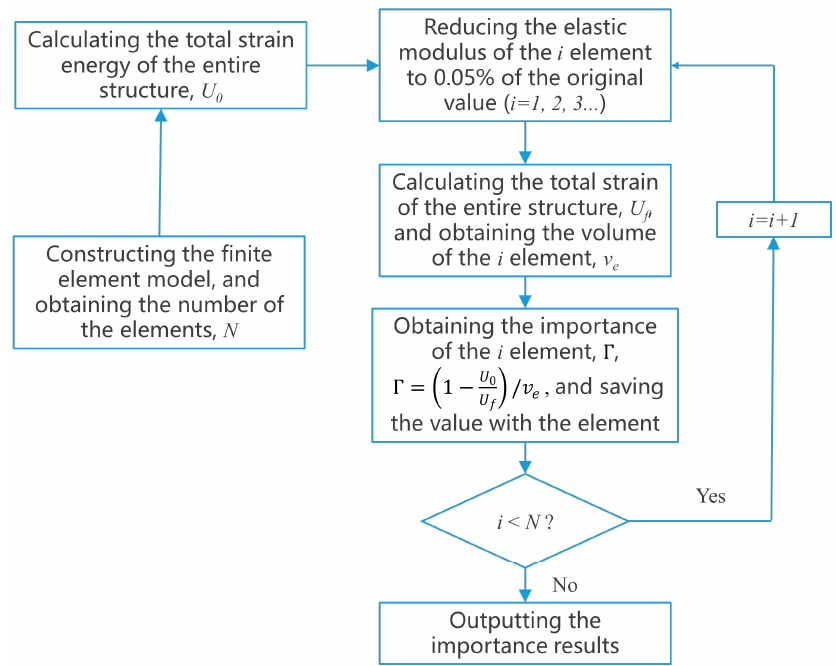
Figure 2. The procedure of the structural component importance analysis.